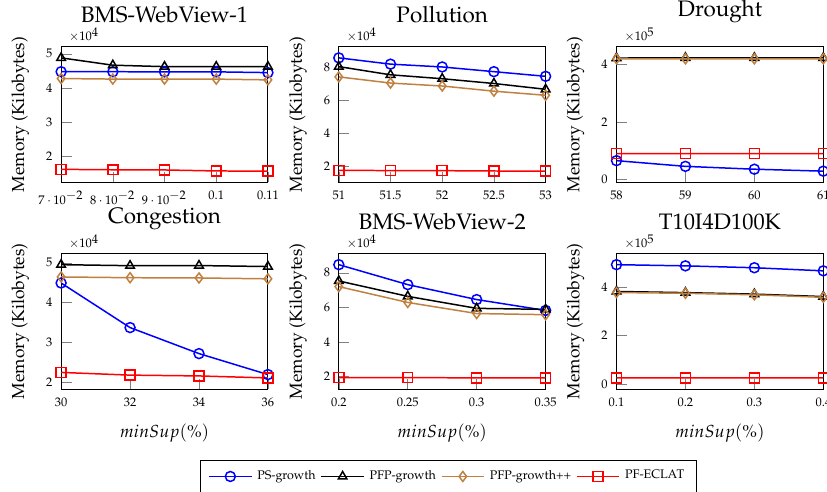
Figure 8. Memory evaluation of algorithms at constant maxPer .